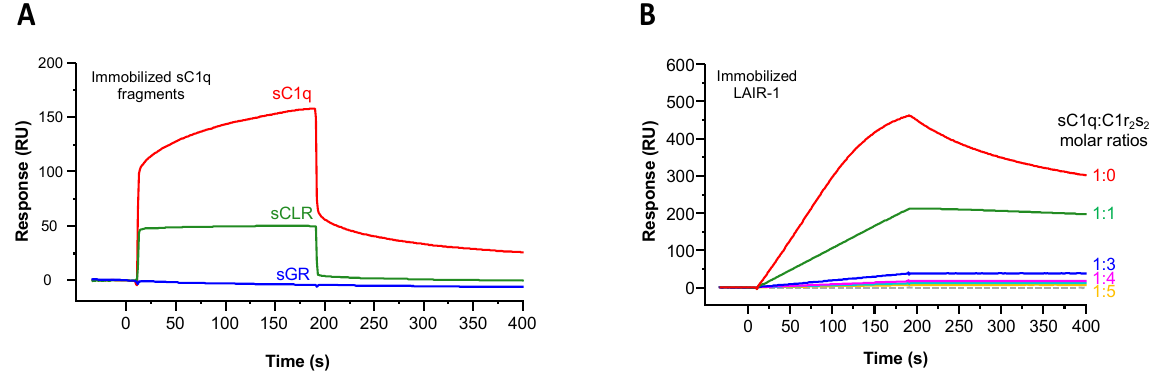
Figure 2. Identification of the C1q functional region interacting with LAIR-1 and competition assay with the C1r 2 s 2 tetramer. ( A ) LAIR-1 (10 µ M) was injected over immobilized serum-derived C1q (sC1q, red curve), sCLR (green curve) or sGR (blue curve). ( B ) sC1q (1 nM) was preincubated with C1r 2 s 2 at increasing molar ratios (1–5) and injected over immobilized LAIR-1. The grey dashed line represents the C1r 2 s 2 tetramer injection at a concentration of 10 nM as a